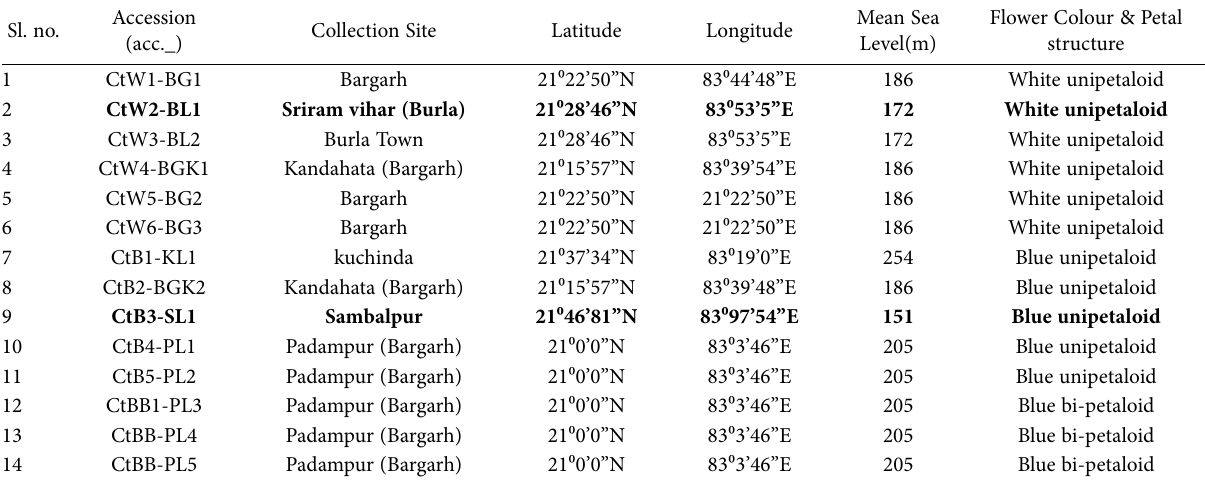
Table 1. Fourteen accessions of C. ternatea with their flower colour, petal configuration and the geographical coordinates of collection sites located in Odisha, India. Sl.